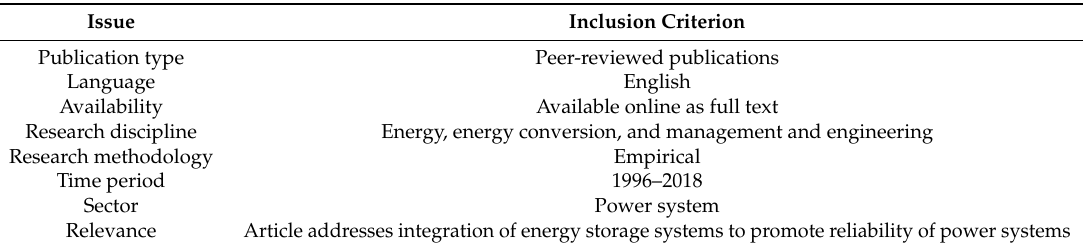
Table 1. Selection criteria of systematic literature